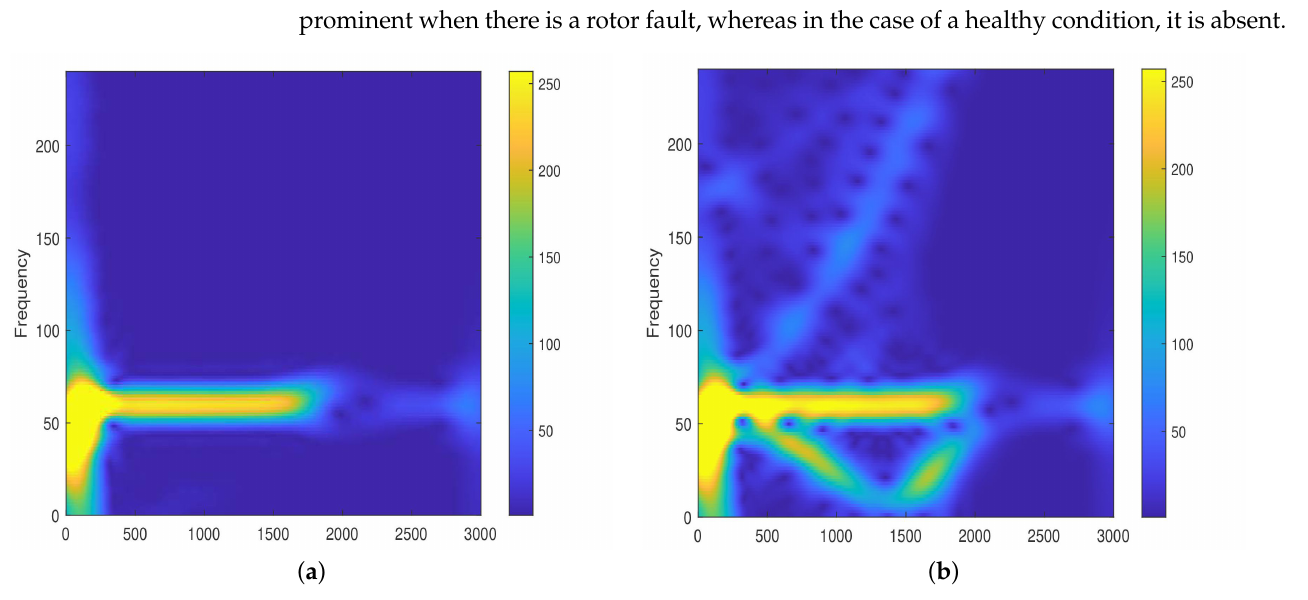
Figure 6. STFT of motor start-up current. ( a ) Healthy; ( b ) one broken